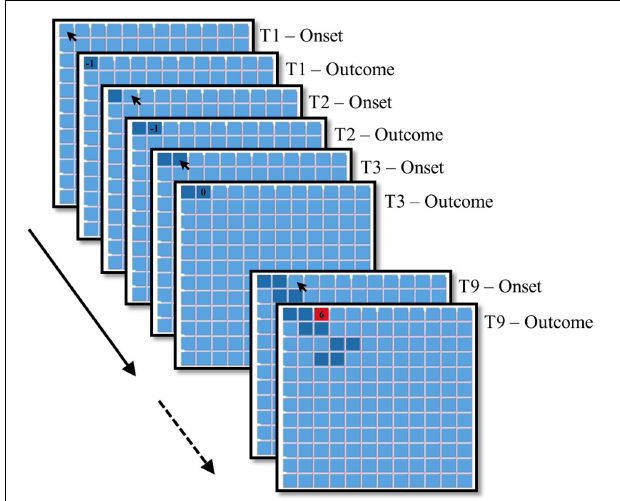
FIGURE 1 | Examples of experimental screens for a hypothetical participant playing the first T = 9 trials in Study 1. Feedback regarding the trial’s outcome appeared for 1 s, after which the trial’s payoff disappeared and participants could choose again the same/another key.